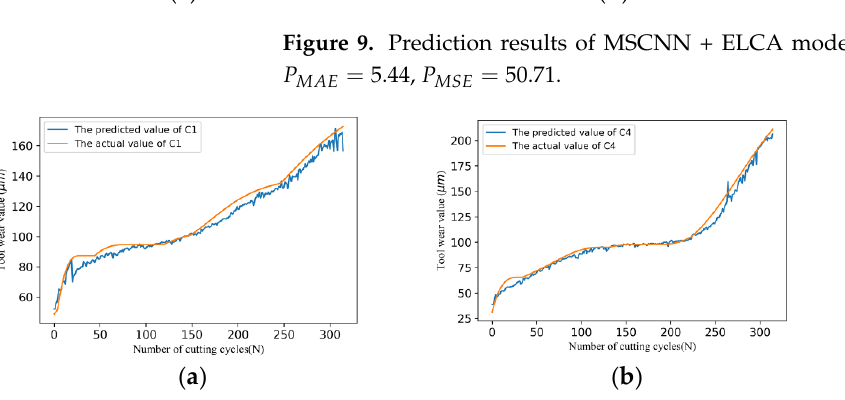
Figure 10. Prediction results of MSCNN+MAS model on datasets. ( a ) C1, ( b ) C4, and ( c ) C6. 𝑃 𝑀𝐴𝐸 = 5.59 , 𝑃 𝑀𝑆𝐸 = 45.92